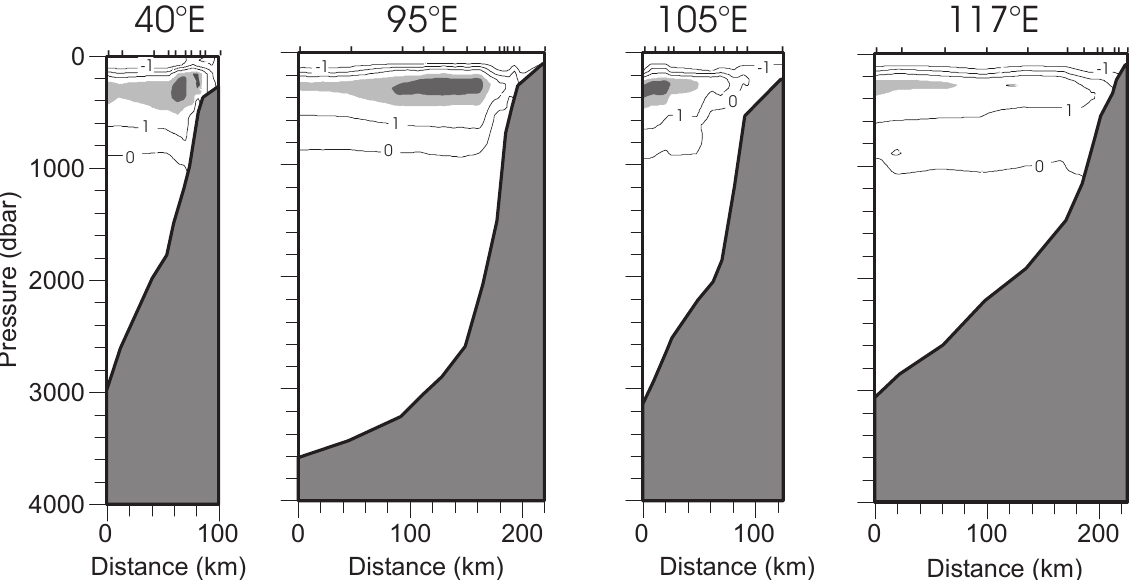
Fig. 14. Sequence of temperature sections along the continental slope of the Nansen Basin (at 40 ◦ E and 125 ◦ E from ARKIX-4 1993, at 95 ◦ E from ARKXII 1996 and at 105 ◦ E from ARKXI- 1 1995). The light/dark shading means temperatures greater than 2 ◦ C / 2.5 ◦ C,